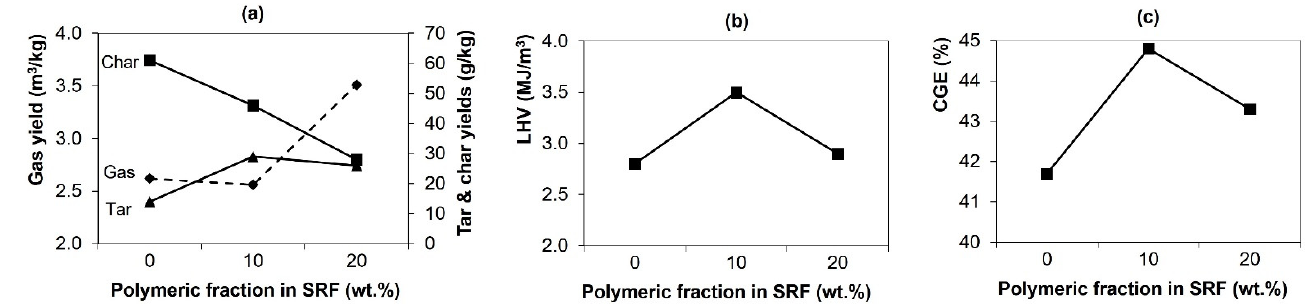
Figure 5. Summary of the effect of SRF polymeric fraction in some gasification parameters: ( a ) product yields, ( b ) lower heating value (LHV) of gas and ( c ) cold-gas efficiency ( CGE ).